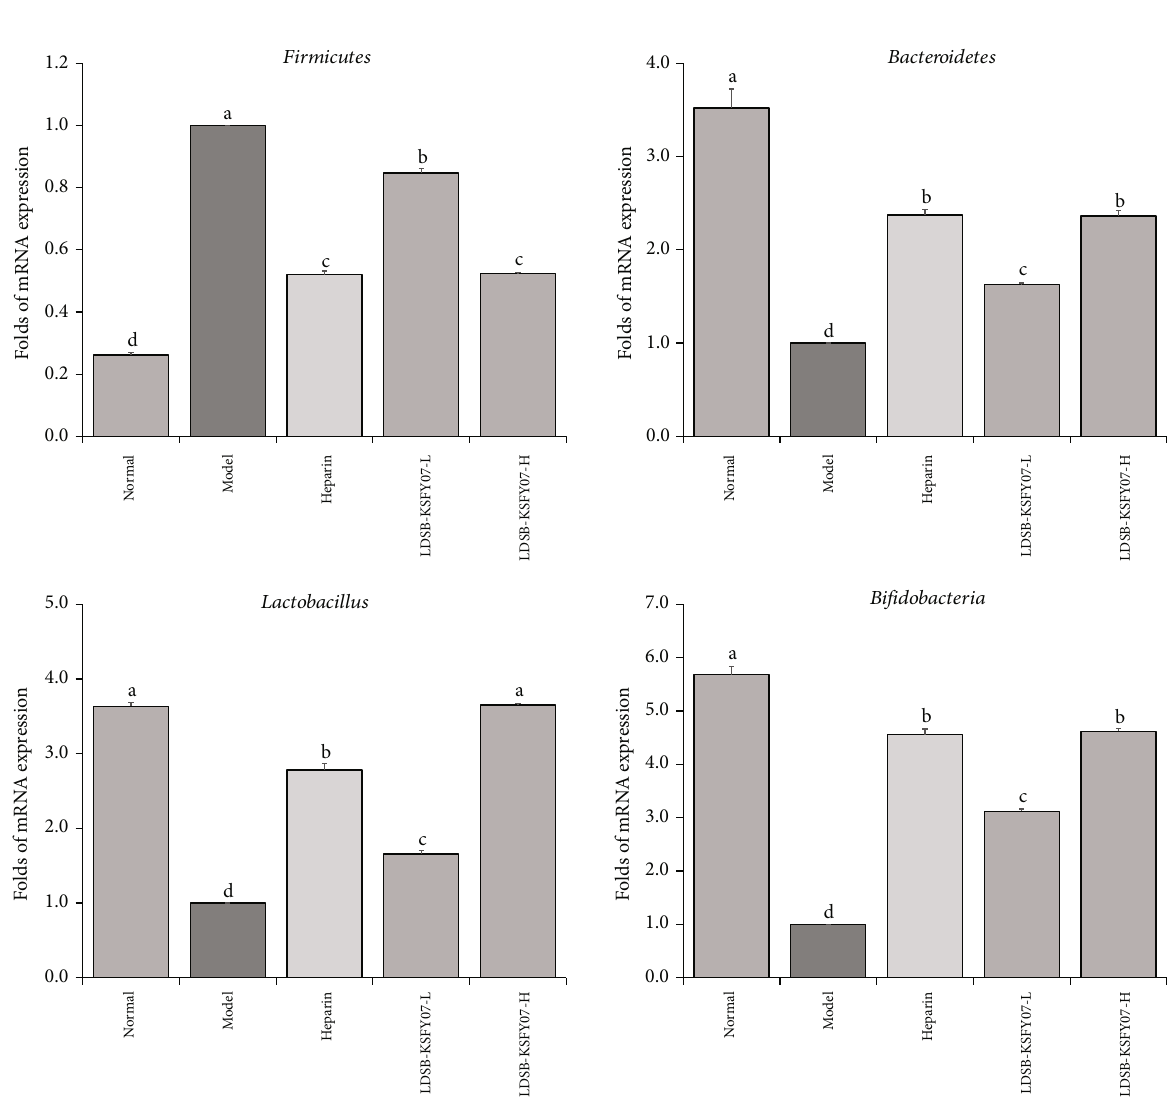
Figure 6: The mRNA expression of Firmicutes , Bacteroidetes , Lactobacillus , and Bi fi dobacteria in faeces of mice with kappa-carrageenan- induced thrombosis. The results have been expressed as mean ± deviation . (A – D) Mean values with di ff erent bars in the di ff erent column are signi fi cantly di ff erent ( P < 0 : 05 ) according to Duncan ’ s multiple range